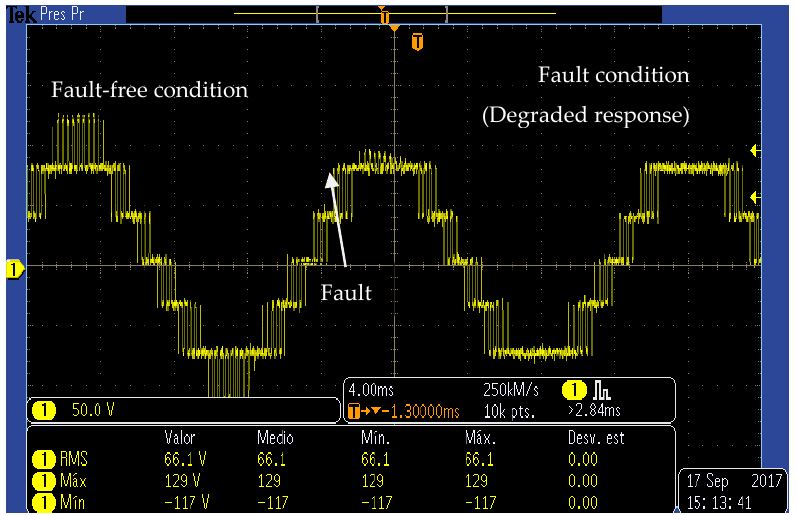
Figure 15. Oscillogram of the output voltage waveform behavior during the change from the fault-free condition to the fault condition (degraded response).